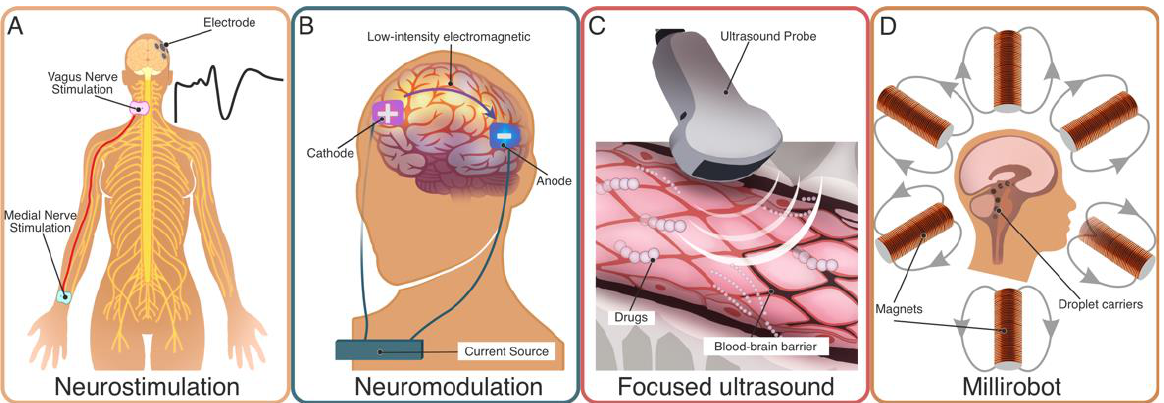
Figure 1. Medical technologies for treatment of Disorders of Consciousness. From left to right: ( A ) neurostimulation, an electrical stimulation to a primary nerve afferent to the brainstem and cortex; ( B ) neuromodulation: a low-intensity electromagnetic treatment delivered to the cortex; ( C ) focused ultrasound: transient, localised, and graded opening of the blood – brain barrier using ultrasounds; ( D ) millirobot: controlled drug delivery to target tissues through soft droplet carriers manipulated by external magnetic fields.